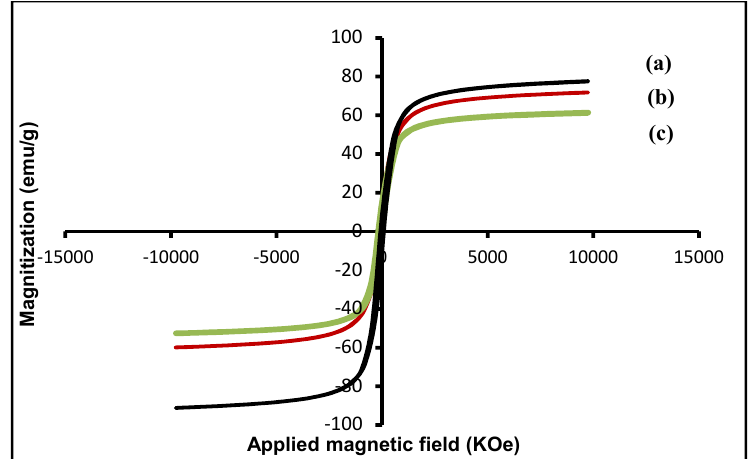
Figure 4. Magnetization curves obtained at different sizes of Fe ( b ) 8.29, and ( c ) 7.83